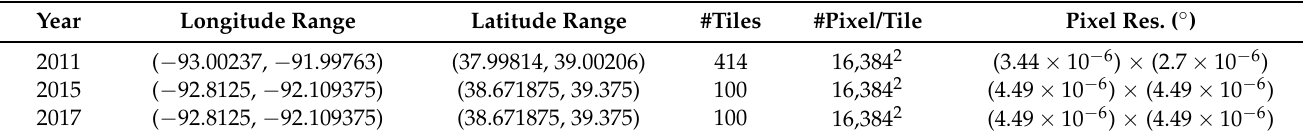
Table 2. CoMo dataset